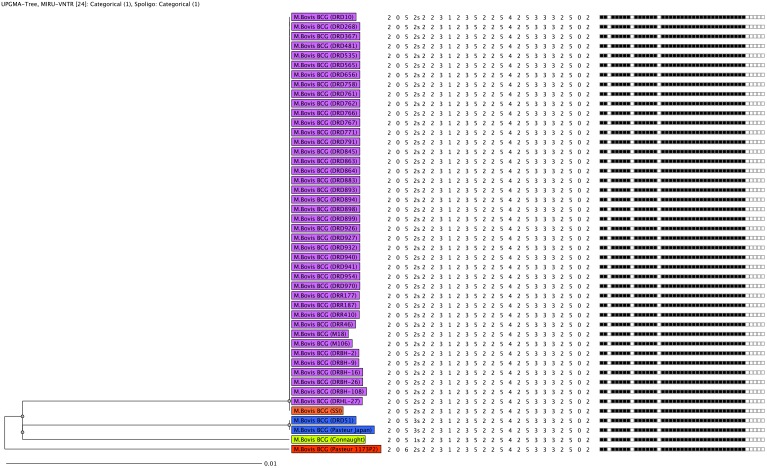
Molecular strain clustering of 42 study isolates and control vaccine strains.The UPGMA tree was built and clusters were identified based on isolates sharing identical MIRU-VNTR types and spoligotypes. Lineages were assigned by best-match analysis followed by tree-based analysis using MIRU-VNTR Plus database. Lineage information followed by isolate identifier number is boxed and colored according to each lineage.